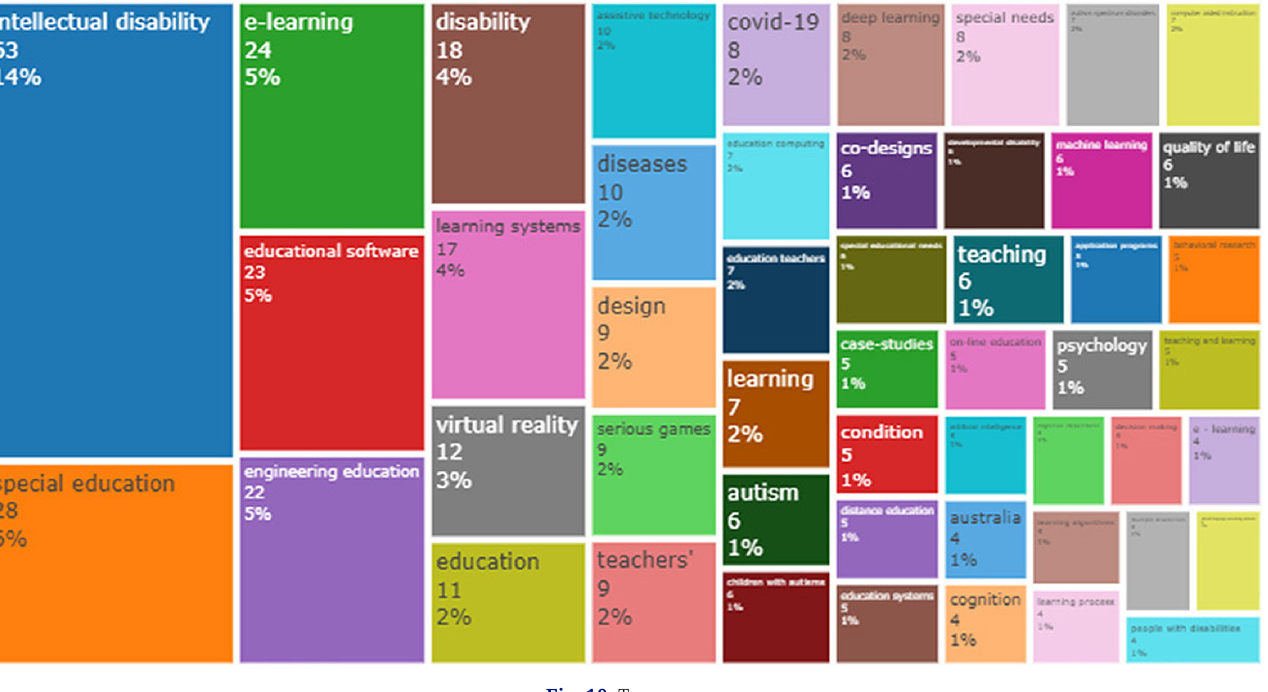
Fig. 10. Tree map